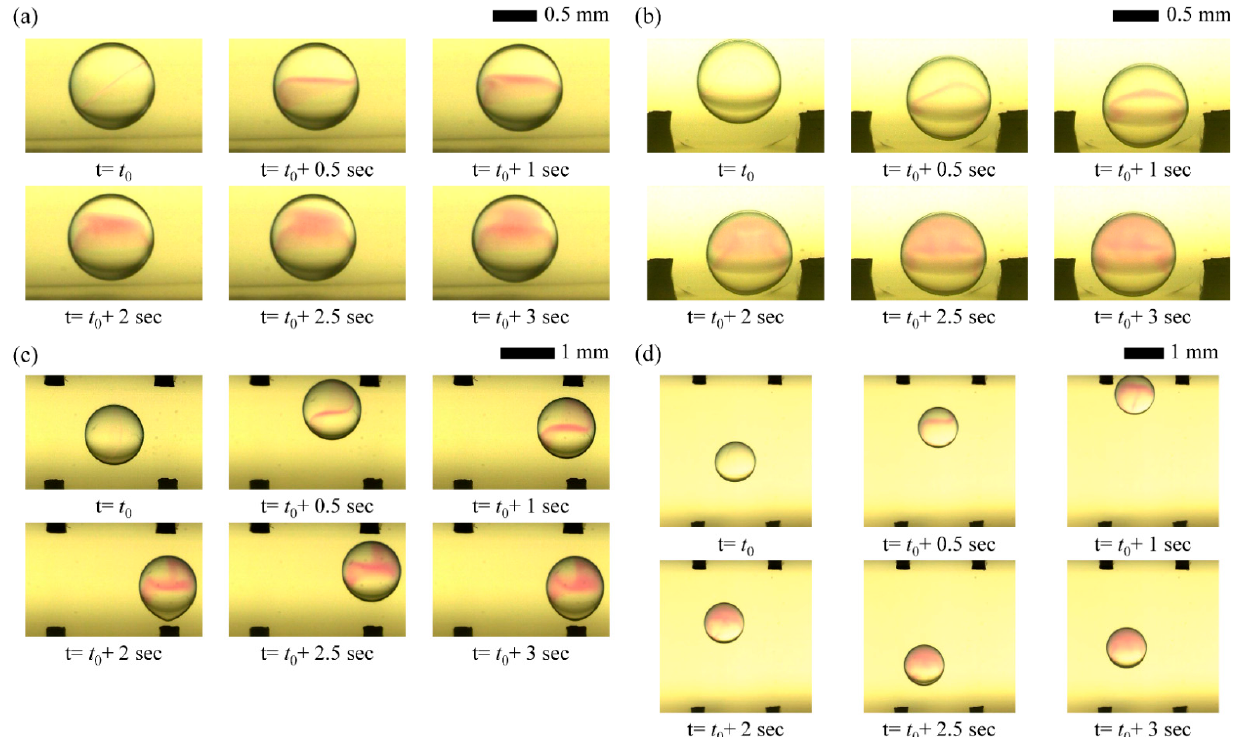
Figure 7. High-speed images of mixing flow patterns driven by ( a ) only diffusion and ( b – d ) reciprocation motions: ( b ) horizontal reciprocation motion with an electrode distance of 2 mm and an applied voltage of 400 V; ( c ) vertical reciprocation motion with an electrode distance of 2 mm and an applied voltage of 400 V; ( d ) vertical reciprocation motion with an electrode distance of 4 mm and an applied voltage of 400 V.